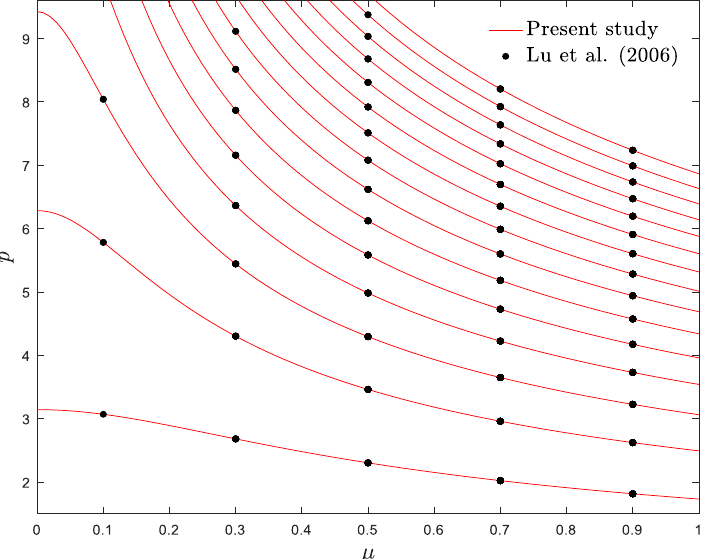
Figure 2. Variations of fifteen eigenvalues of a pinned–pinned nanobeam against nonlocal parameter.